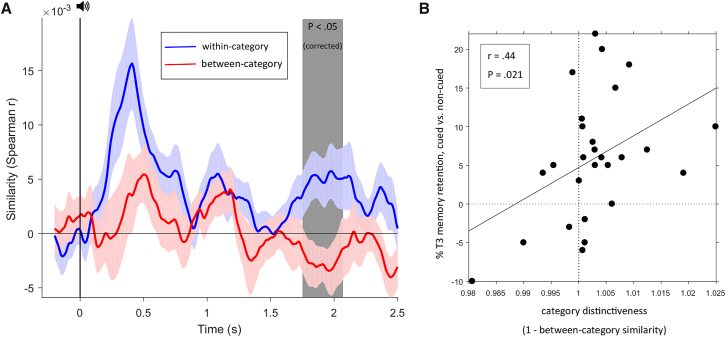
Information Processing Evoked by Memory Cues(A) Time courses (mean ± SEM) of within- and between-category similarities in response to old memory cues. Shaded area from 1.76 to 2.06 s highlights a significant increase (p < .05, corrected for multiple comparisons across time, see also Figure S4).(B) Spearman correlation of category distinctiveness (1 minus between-category similarity from 1.76 to 2.06 s) and the behavioral benefit of cueing on overnight consolidation across participants.